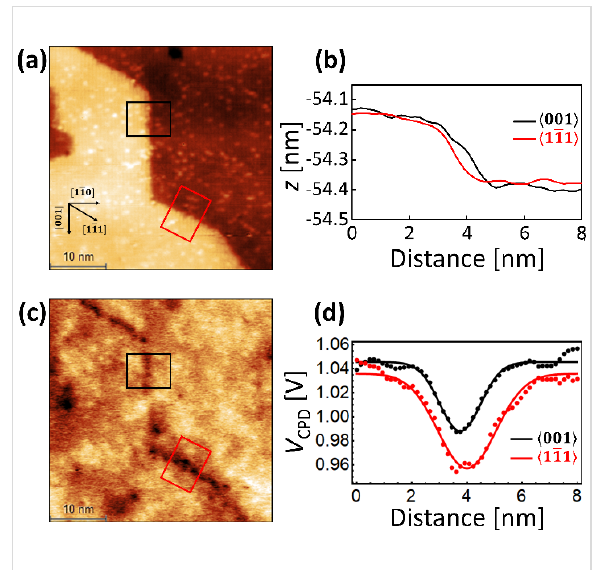
Figure 3: AFM/KPFM images (40 × 40 nm 2 ) of TiO 2 after O 2 expo- sure, showing and steps. (a) Topographic image and (b) average height profiles. (c) CPD image and (d) average CPD profiles. These line profiles show average values from 40 lines perpen- dicular to the steps in the black and red rectangles in (a) and (c). Dots are experimental results in (d) and solid lines are Gaussian fits of the experimental data. The acquisition parameters: Q = 29435, Δ f = − 100 Hz, V DC = 0 V, f AC = 170 Hz and V AC = 1 V.